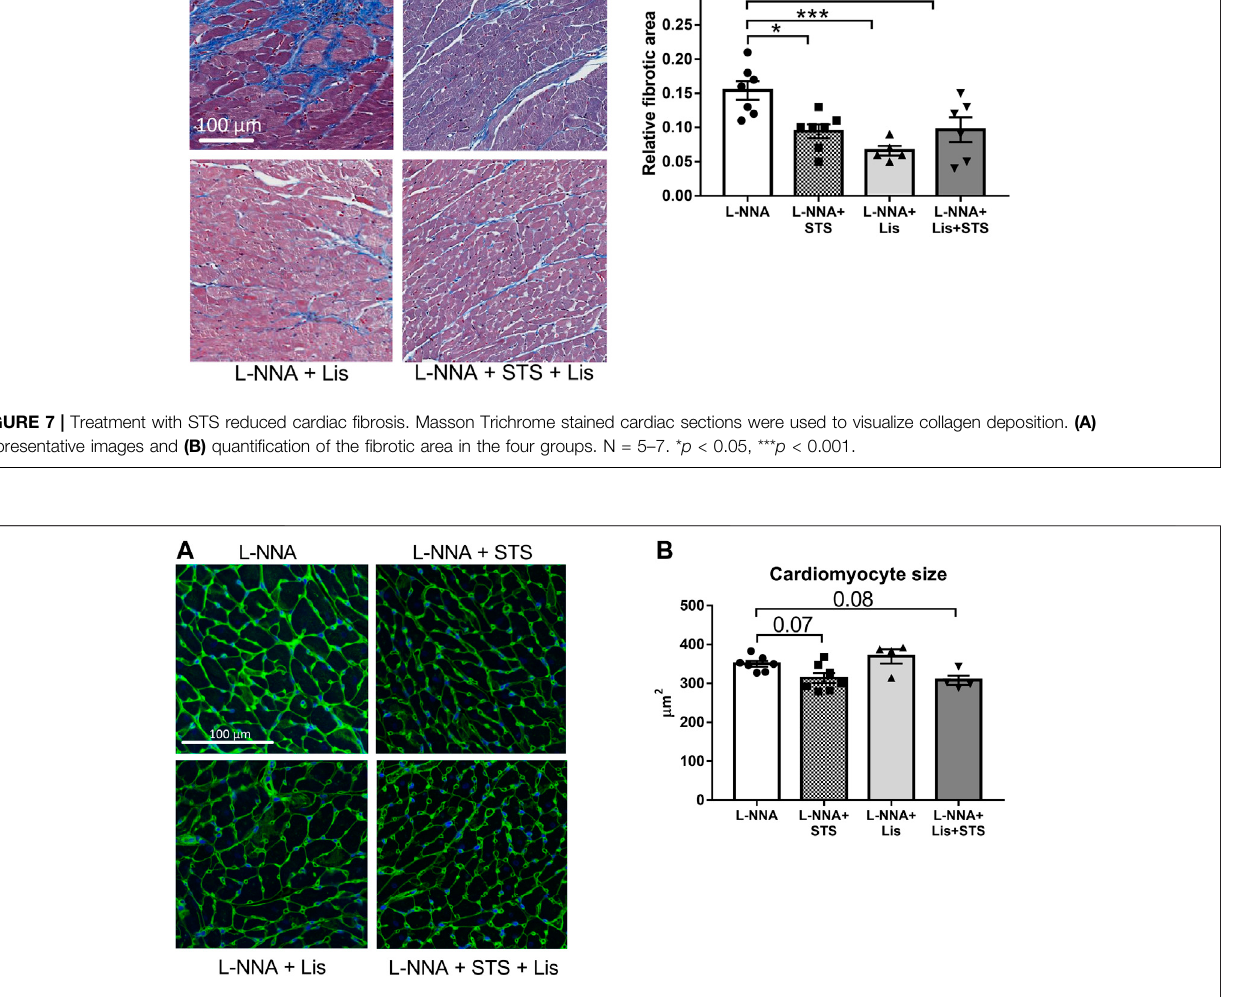
FIGURE 8 | Treatment with STS tends to lower cardiomyocyte hypertrophy. Cardiac sections were stained with Wheat-Germ Agglutinin-FITC to investigate cardiomyocyte size. (A) Representative images and (B) quanti fi cation of the cardiomyocyte cross-sectional area in the four groups. N (cid:2) 4 – 7.